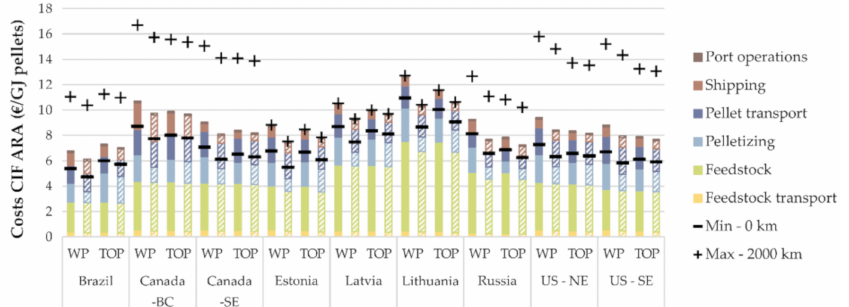
Figure 5. Supply chain costs for wood pellets and torrefied pellets made from pulpwood (solid) and sawmill residues (striped), for all analysed countries. Total costs were based on feedstock transport distance of 50 km and pellet transport distance of 500 km. As a sensitivity, minimum and maximum values are shown based on transport distance of pellets between 0–2000 km. Maximum transport distance in the Baltic States remains 500 km, which is the maximum distance possible in these smaller countries. Shipping transport was calculated for Handymax ships, except for the Baltic States in which case the use of a short sea ship was assumed.